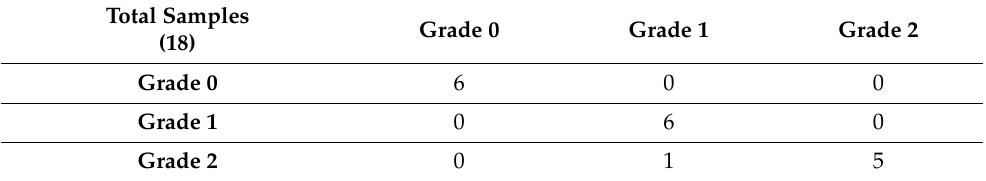
Table 4. Testing confusion matrix of SGDM empowered with AlexNet (non-augmented test data).